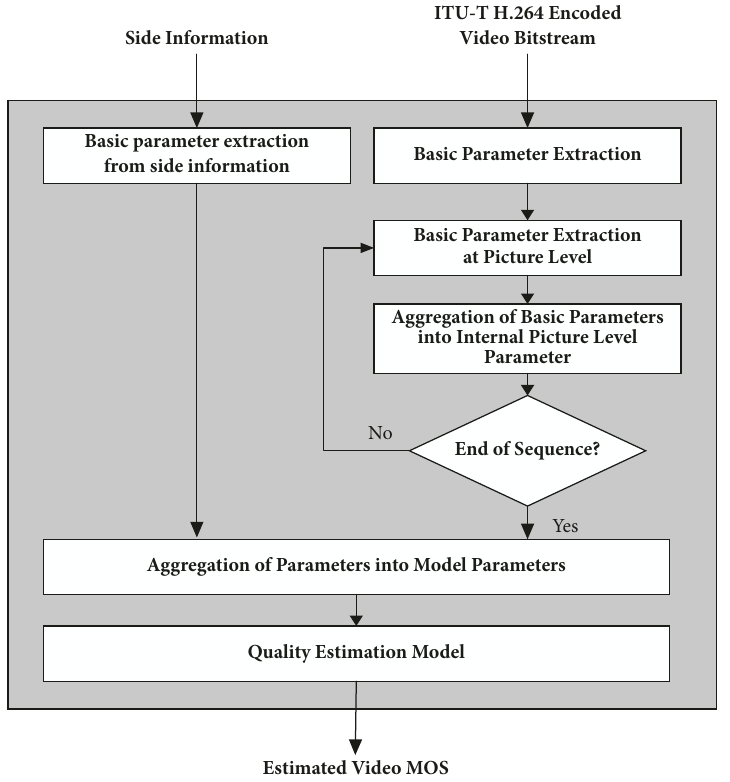
Figure 22: Block diagram of ITU-P.1202.1 model. Table 11: Application areas, test factors, and technology used by the ITU-T J.247